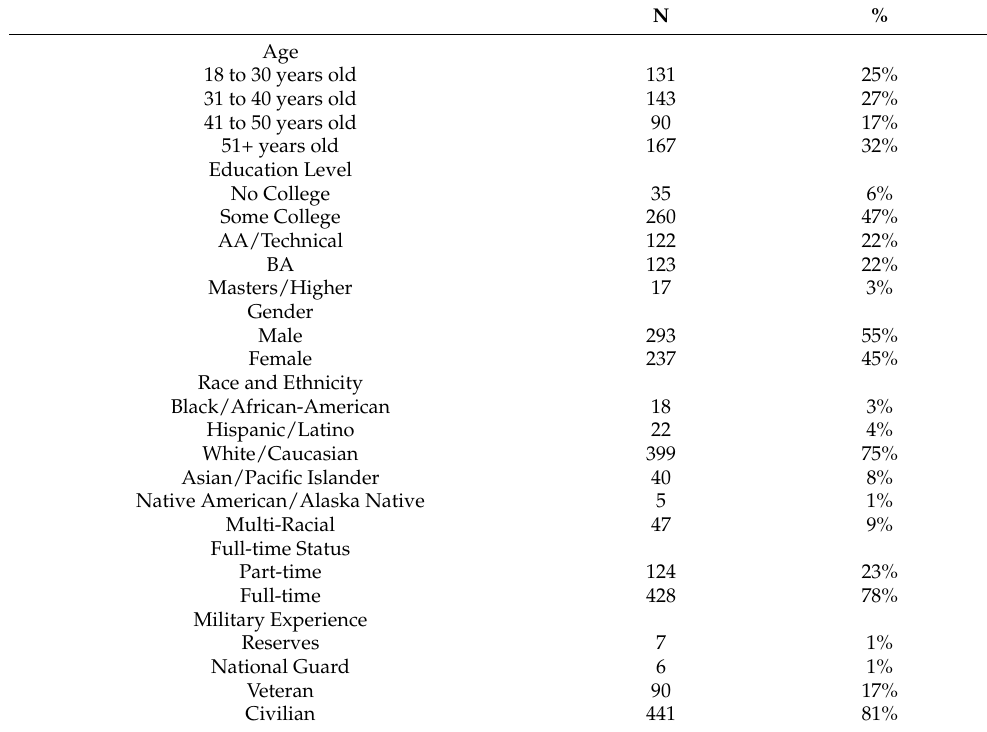
Table 2. Respondents’